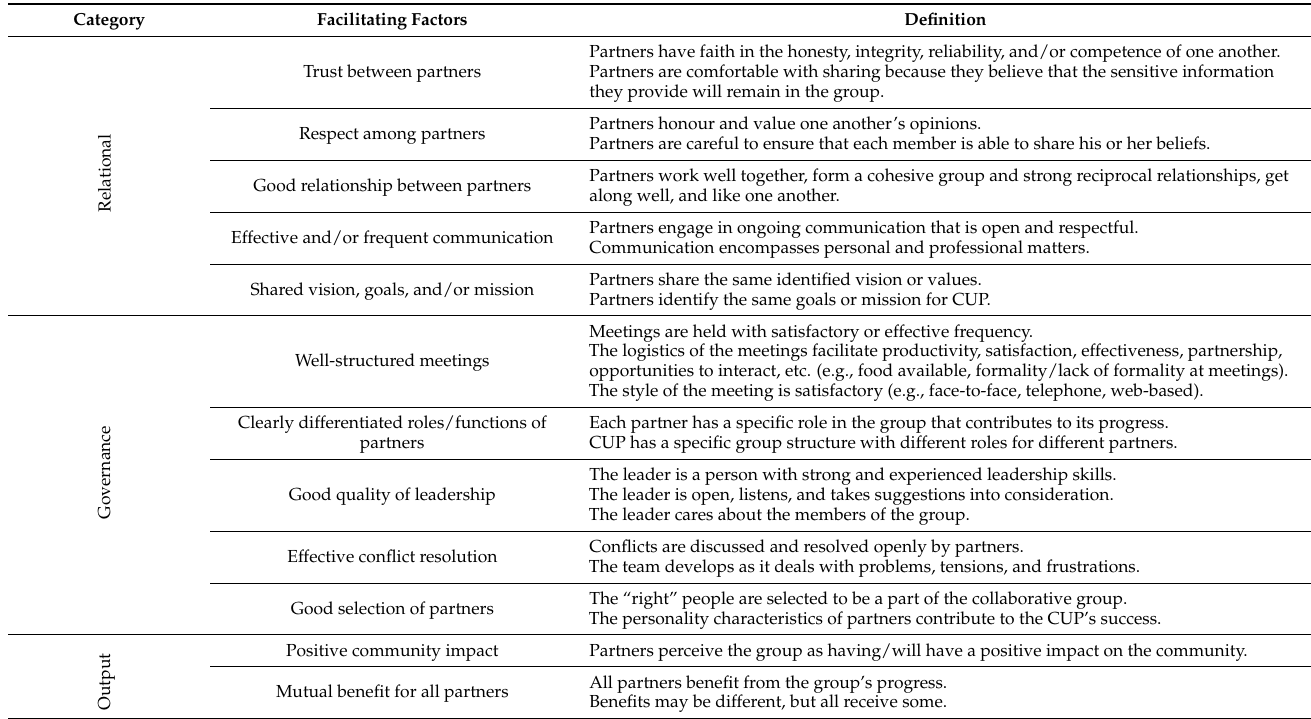
Table 1. Facilitating factors of